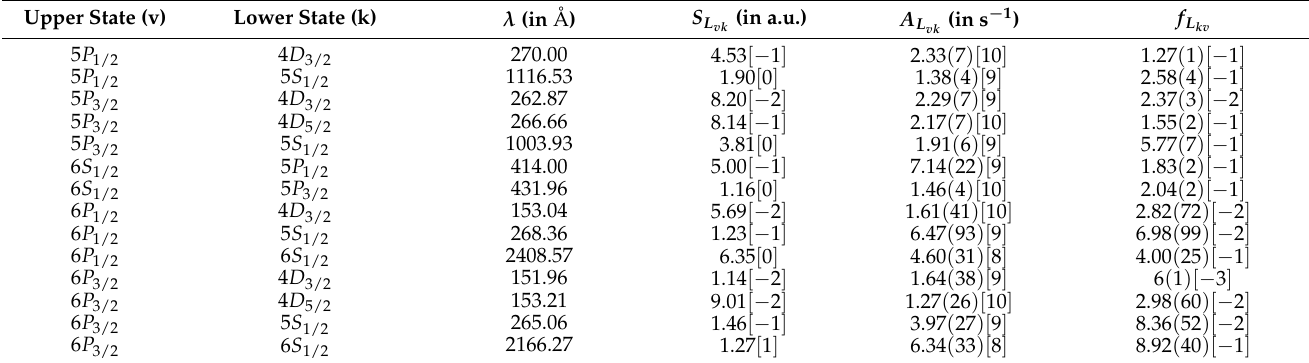
Table 4. The L-gauge line strengths ( S L ( A L ) in (s − 1 ) and absorption oscillator strengths ( f L vk Values in square brackets represent the order of 10. Uncertainties are given in parentheses.